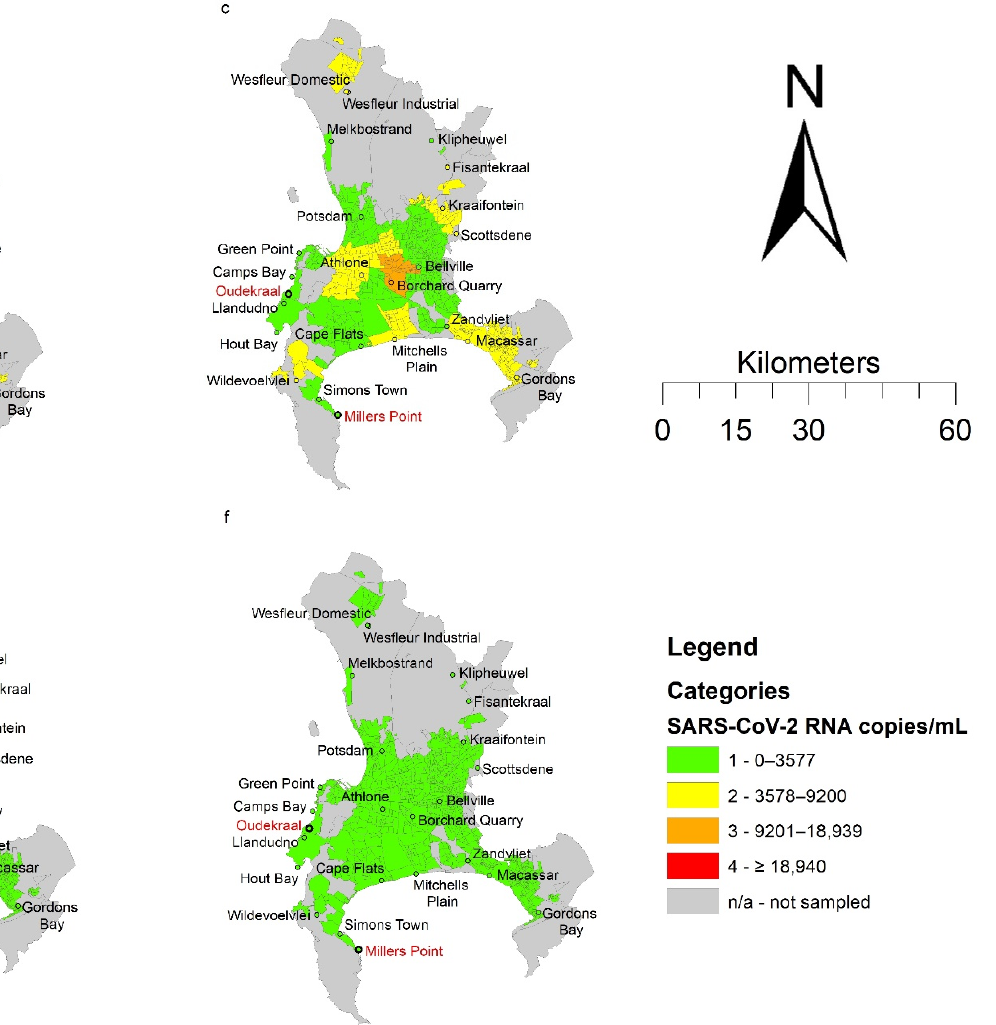
Figure 1. Spatial representation of SARS-CoV-2 RNA/mL in wastewater from 23 wastewater treatments plants and related catchment areas (suburbs) in the City of Cape Town at 6 sampling timepoints: ( a ): 6 July 2020 (week 1); ( b ): 13 July 2020 (week 2); ( c ): 20 July 2020 (week 3); ( d ): 27 July 2020 (week 4); ( e ): 3 August 2020 (week 5); ( f ): 10 August 2020 (week 6).